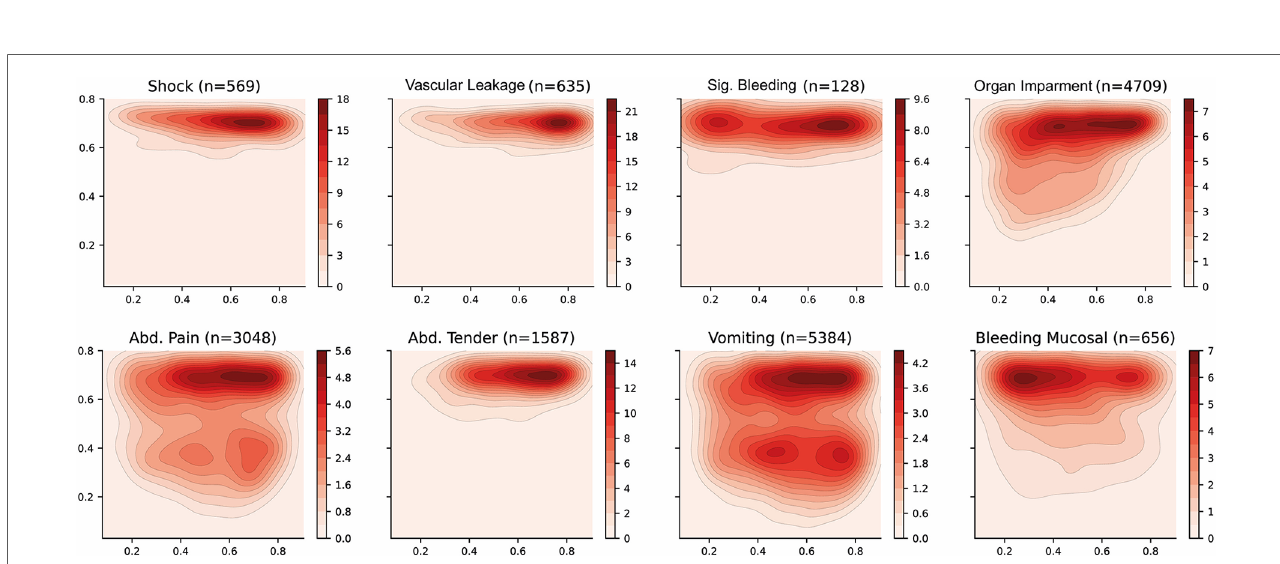
FIGURE 5 Latent space description: Phenotypes. The graphs represent the density distribution using contour lines estimated using a Gaussian kernel over the latent space. The title includes the phenotype and the number of patients in which it occurs. The de fi nition of the compound categories (vascular leakage, signi fi cant bleeding and organ impairment) are de fi ned in Table 2 . A detailed set of graphs describing other phenotypes has been included in Figure A2 (Appendix) .